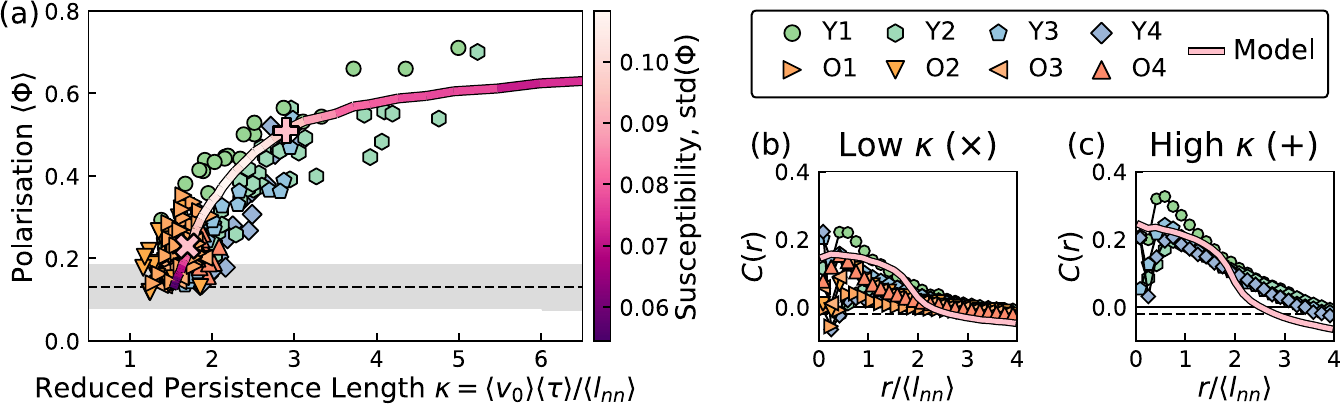
Fig 4. Single–parameter description of the Zebrafish system. A: The average polarisation h F i as a function of the reduced persistence length κ , where most data points collapse, and agree with the simulation result of the inertial Vicsek model. The dashed line and grayscale zone represent the expected average value and standard deviation of h F i for the uniform random sampling of vectors on the unit sphere. B: The velocity correlation function of the fish and the model in the low κ states, highlighted in A with a × symbol. C: The velocity correlation function of the fish and the model in the high κ states, highlighted in A with a +